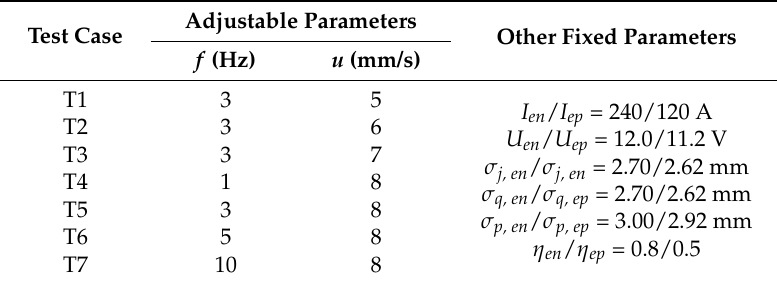
Table 2. Parameters for VP-GTA welding of